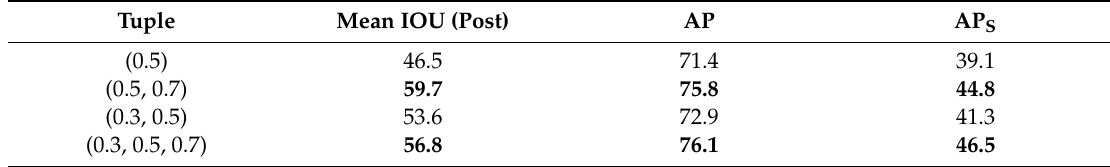
Figure 12. Sample RPN proposals from Faster R-CNN and C-G RPN.